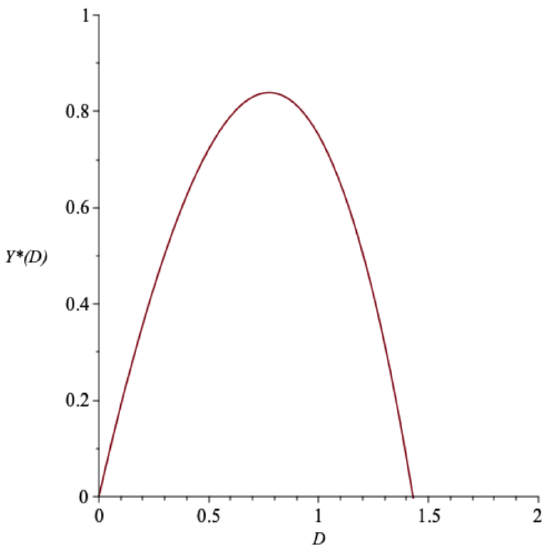
Figure 2. Output product flux at equilibrium with respect to dilution rate. Parameters set: s in = 2, µ max = 5 and k = 5. In this case, s ∗ = 0.88 and x ∗ = 1.12. Yield Y ∗ ( D ) shows a maximum.